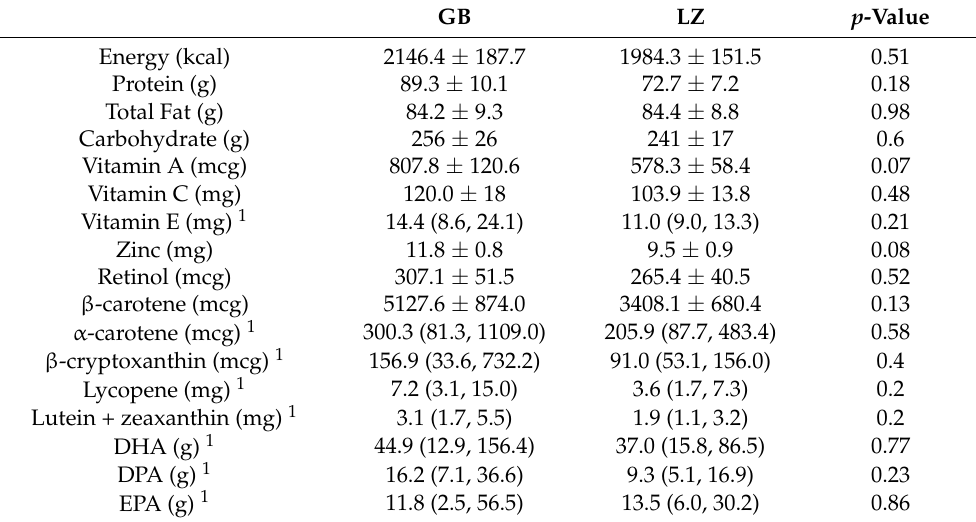
Table 1. Mean intake of select dietary nutrients, apart from intake of goji berries (GB) or lutein and zeaxanthin (LZ) supplementation, collected once between day 0 and day 45, and again between day 45 and day 90.